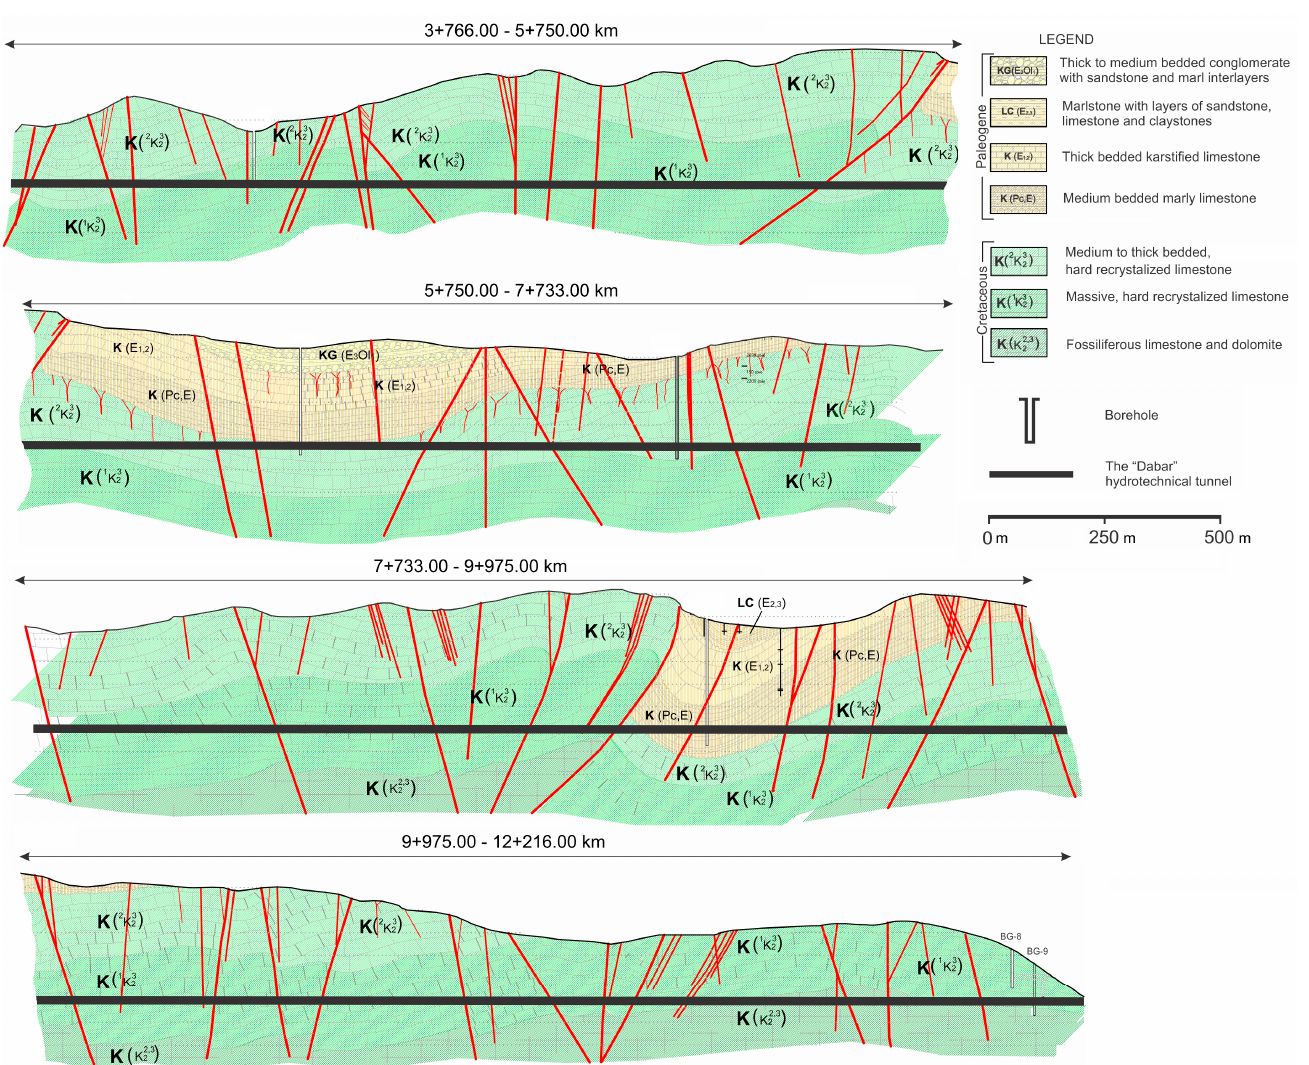
Figure 3. Longitudinal cross-section along tunnel axis in Cretaceous limestone with major geological units.